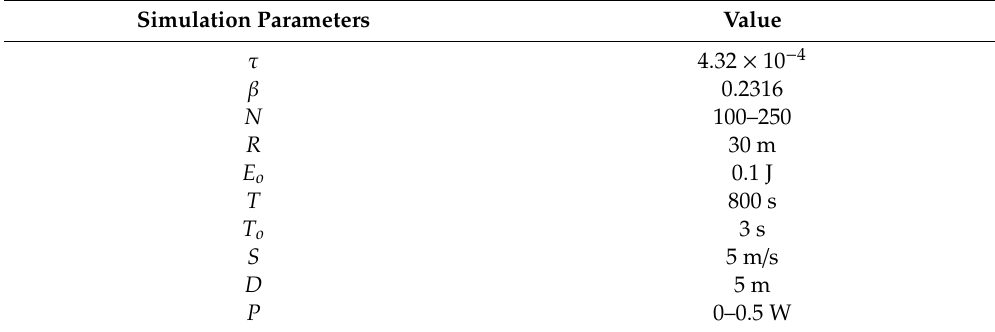
α Figure 3. Impact of on average moving time (P = 0.3 W). Figure 3. Impact of α on average moving time (P = 0.3